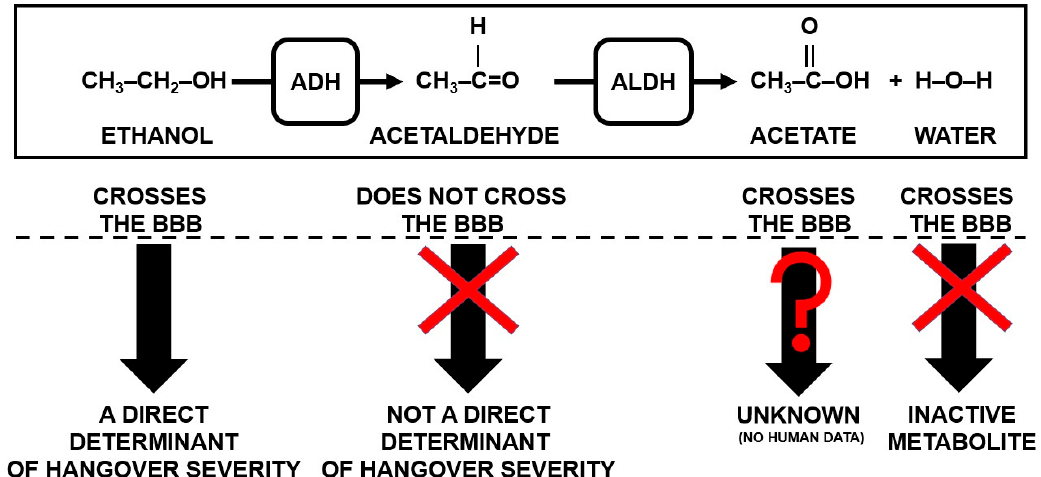
Figure 1. Alcohol metabolites and their hypothesized impact on the presence and severity of alcohol hangover. Abbreviations: BBB = blood brain barrier, ADH = alcohol dehydrogenase, ALDH = aldehyde dehydrogenase.